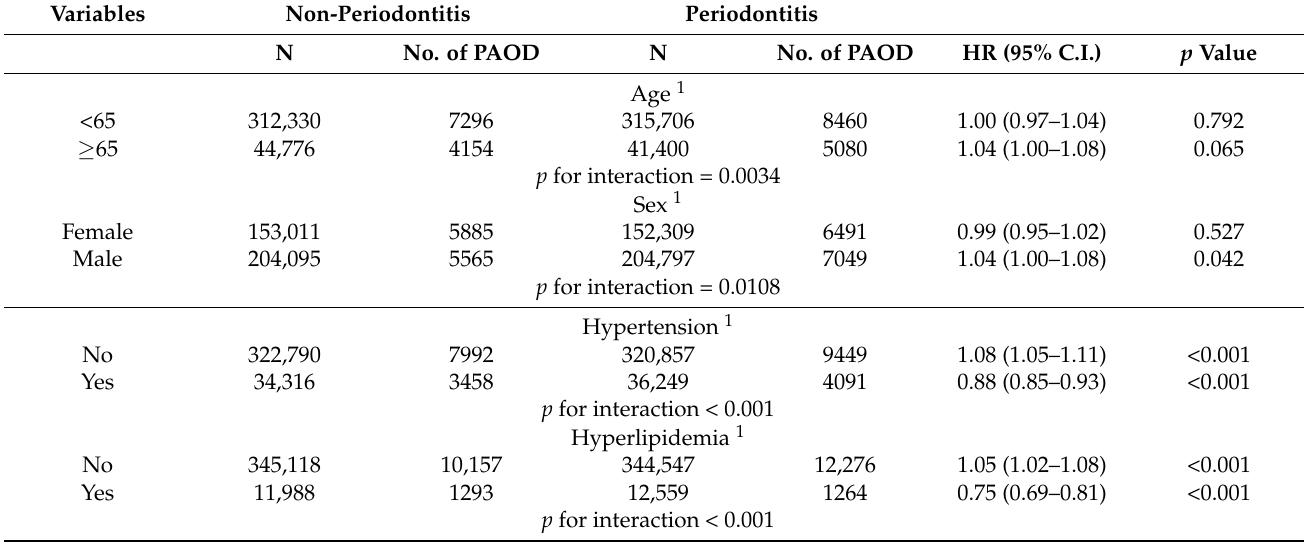
Table 4. Subgroup of Cox proportional hazard model